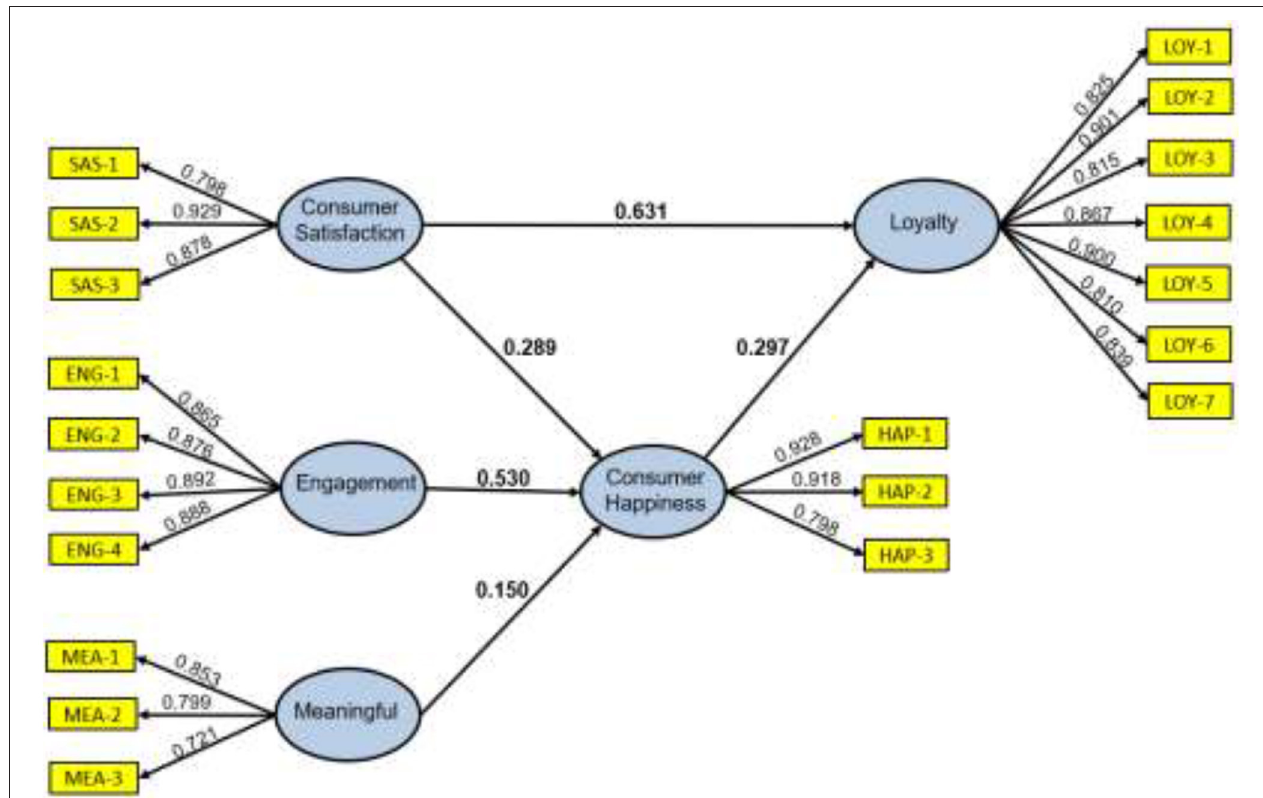
FIGURE 2 | Conceptual model